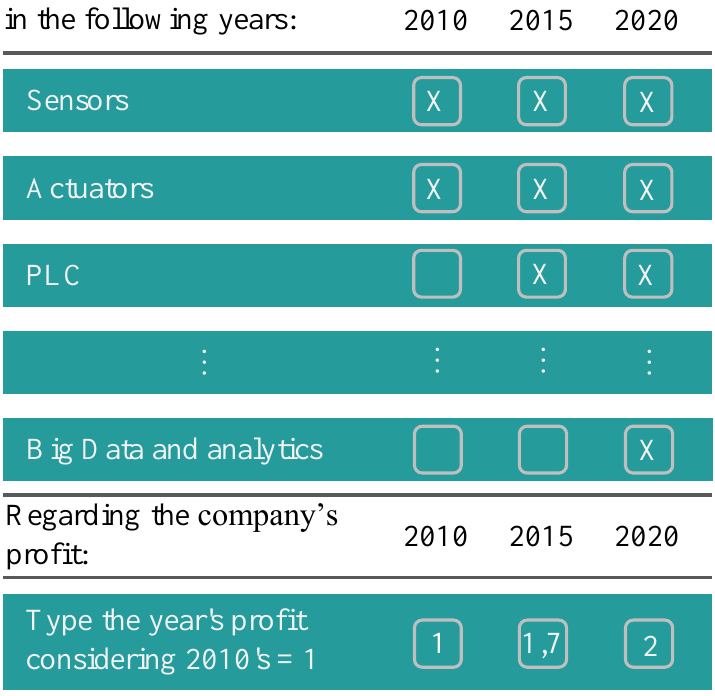
Figure 3. Exemplary questions and possible answers to the questionnaire